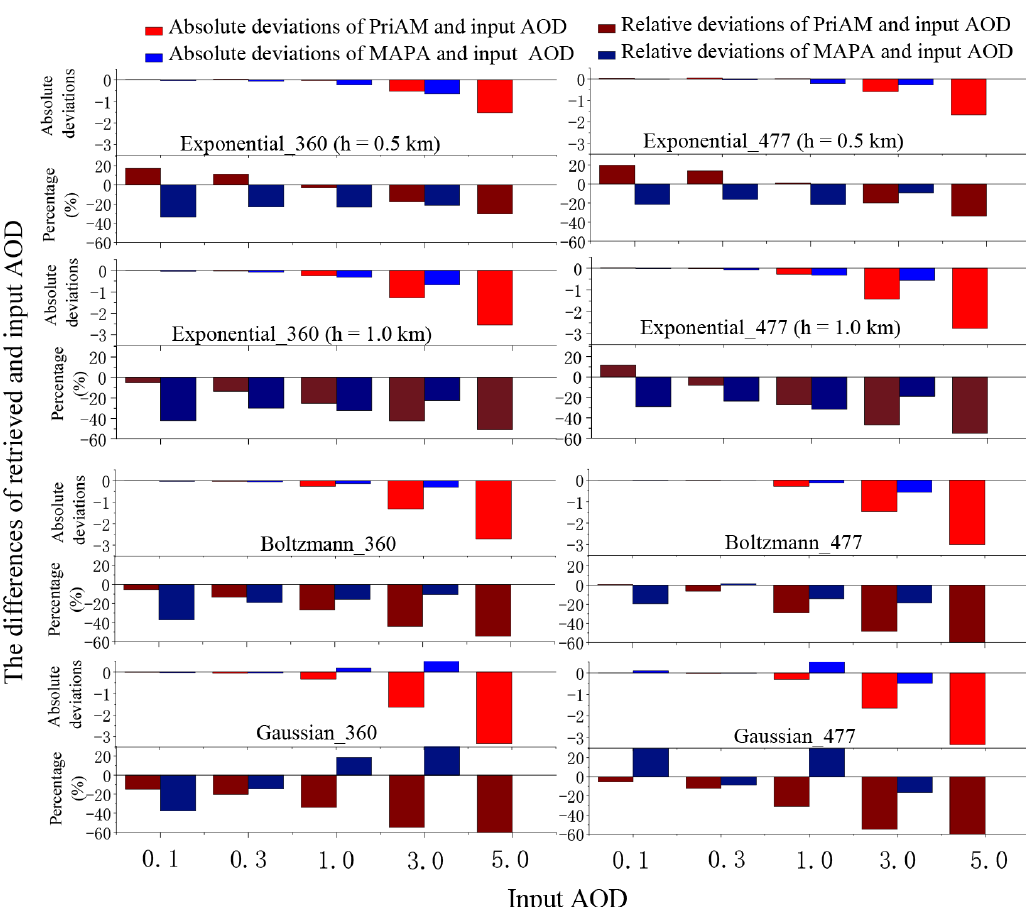
Figure 8. Comparison between the retrieved AODs and input AODs for PriAM and MAPA for the four aerosol profile shapes listed